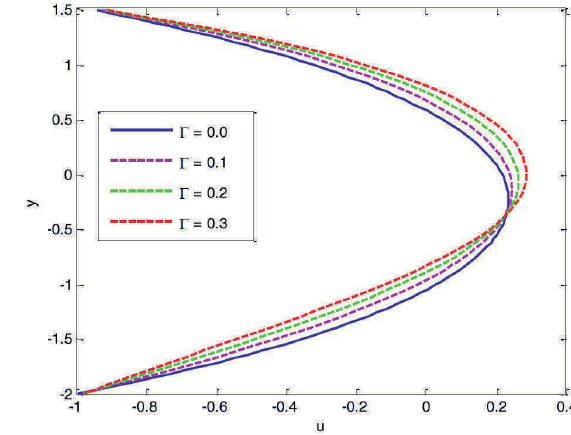
Fig. 4: Impact of Hartmann number Ha on velocity.